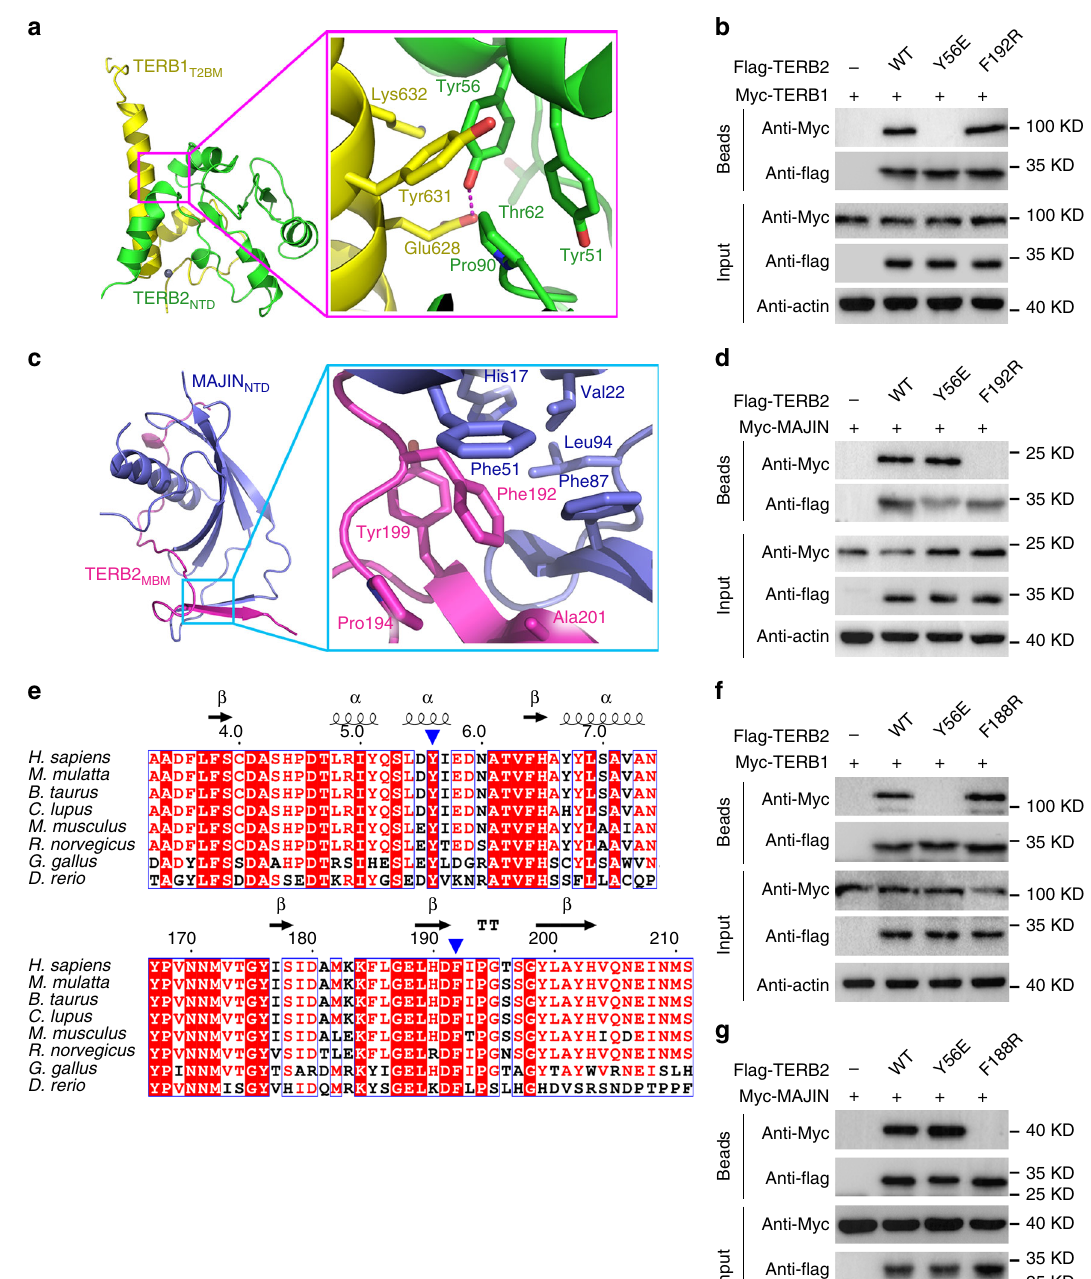
Fig. 4 Mutational analyses of the TERB1 – TERB2 and TERB2 – MAJIN interactions. a , c Detailed interactions around Tyr56 TERB2 in the TERB1 T2BM – TERB2 NTD complex ( a ) and around Phe192 TERB2 in the TERB2 MBM – MAJIN NTD complex ( c ). b , d Co-immunoprecipitation (Co-IP) of human TERB1 ( b ) or MAJIN ( d ) with wild-type (WT) or mutant Flag-tagged human TERB2 in 293T cells. The levels of each protein in the input and IP samples were analyzed by immunoblotting with the indicated antibodies. Input contains 5% of the input whole-cell lysate used for IPs. e Multiple sequence alignment of the N- terminal (top) and C-terminal (bottom) regions of TERB2 required for its association with TERB1 and MAJIN, respectively. Sequence positions are shown based on the human TERB2. The residues of Tyr56 (Try56 in mouse) and Phe192 (Phe188 in mouse) are indicated by blue arrowheads. f , g Co-IP of mouse TERB1 ( f ) or mouse MAJIN ( g ) with WT or mutant Flag-tagged mouse TERB2 in 293T cells. The levels of each protein in the input and IP samples were analyzed by immunoblotting with the indicated antibodies. Input contains 5% of the input whole-cell lysate used for IPs. Source data are provided as